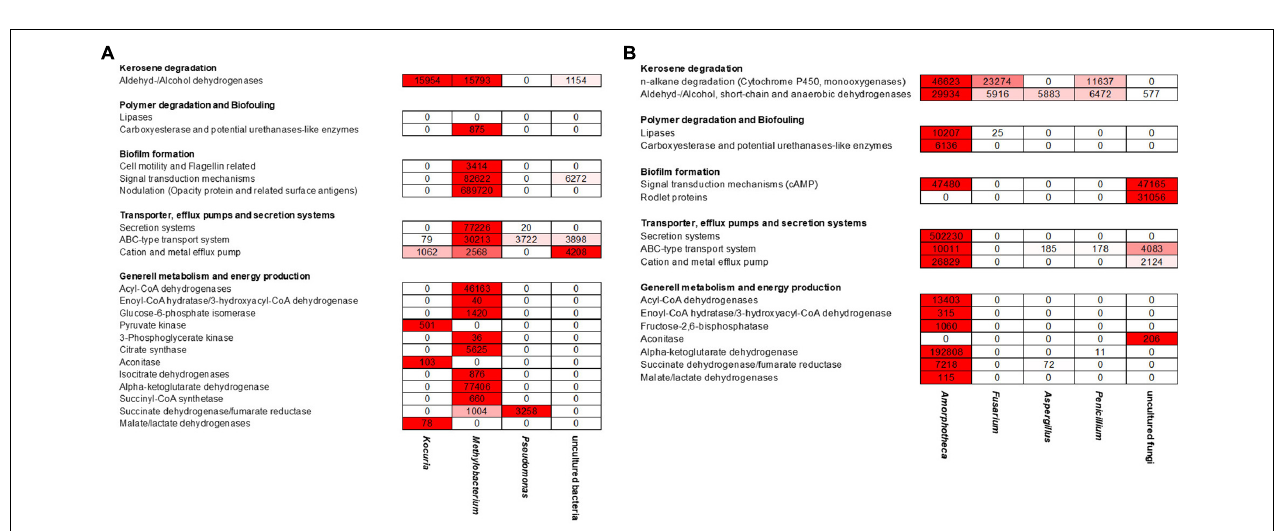
FIGURE 4 | Transcribed microbiome and expressed genes of (A) bacterial and (B) fungal classes of one biofilm sample from a fuel-containing habitat. The generated sequence data (approximately 132 mio reads) were mapped to the available six metagenomes.